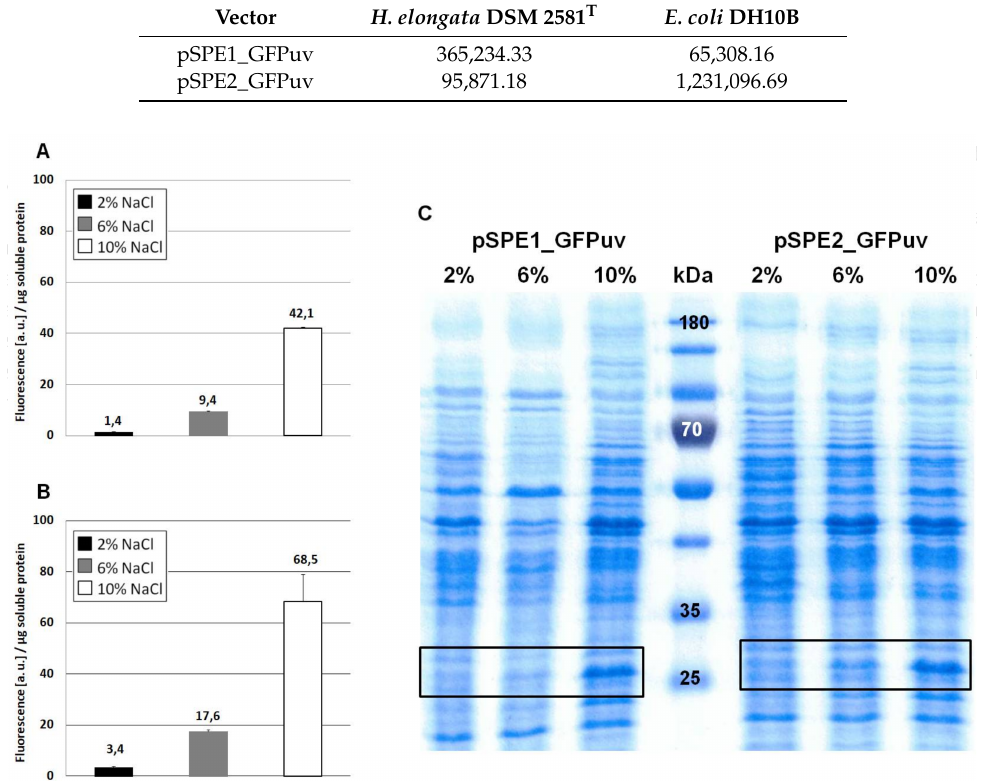
Figure 4. Expression of GFPuv in H. elongata , part II. Strains expressing the reporter protein GFPuv were grown in MM63 medium at constant NaCl concentrations (2%, 6% or 10% w/v ) until early stationary phase. Then, cultures were harvested and soluble protein fractions were isolated, purified and used for fluorescence measurements and SDS-PAGE. ( A ) H. elongata pSPE1_GFPuv, ( B ) H. elongata of soluble protein fractions of respective H. elongata strains. GFPuv has a size of 26.8 kDa,